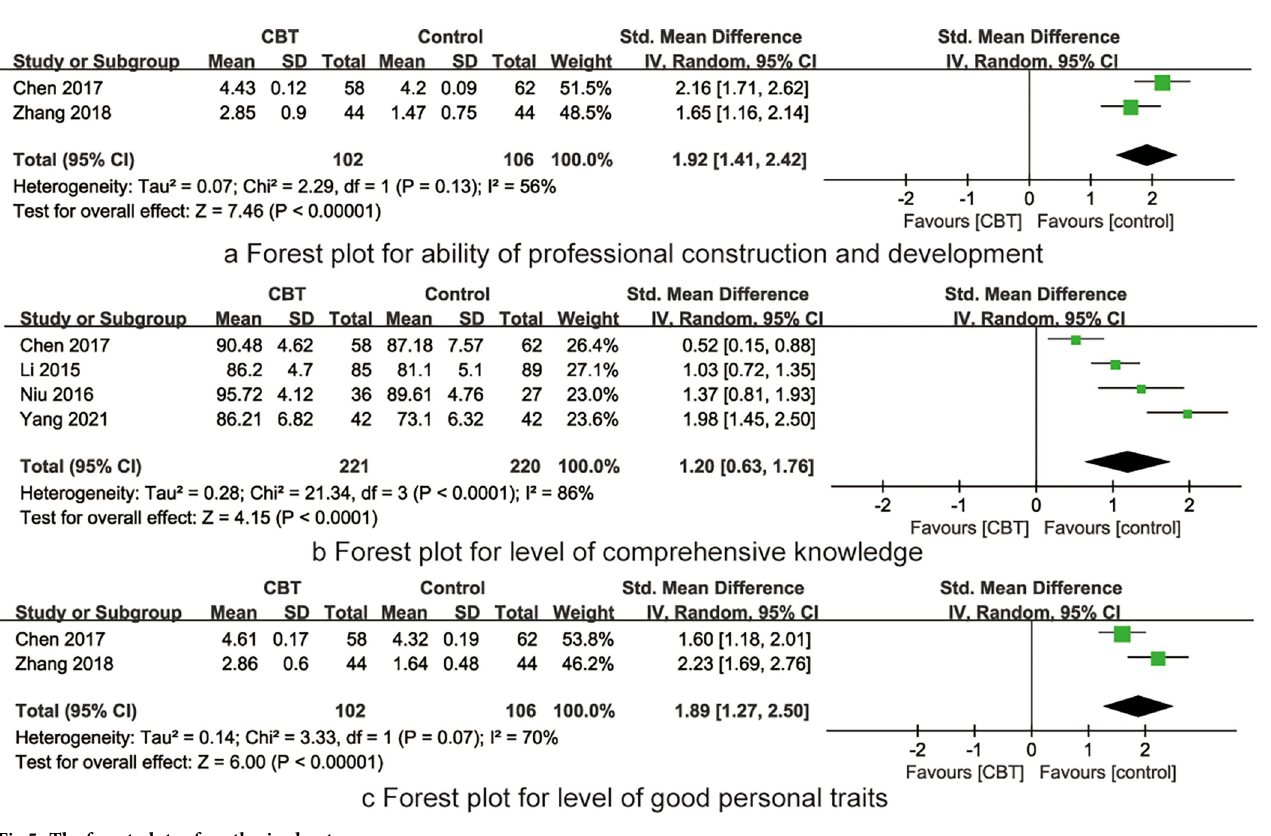
Fig 5. The forest plots of synthesized